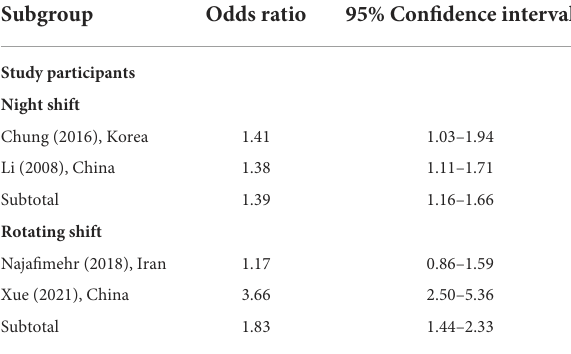
TABLE 3 Subgroup analysis of odds ratio based on whether the participants were rotating shift or night